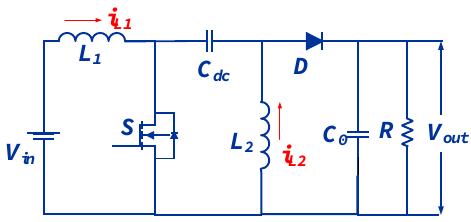
Figure 6. Configuration of a single ended primary inductance converter (SEPIC) converter.